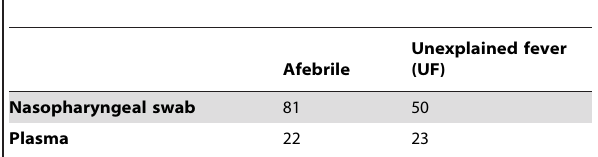
Table 2. Samples.